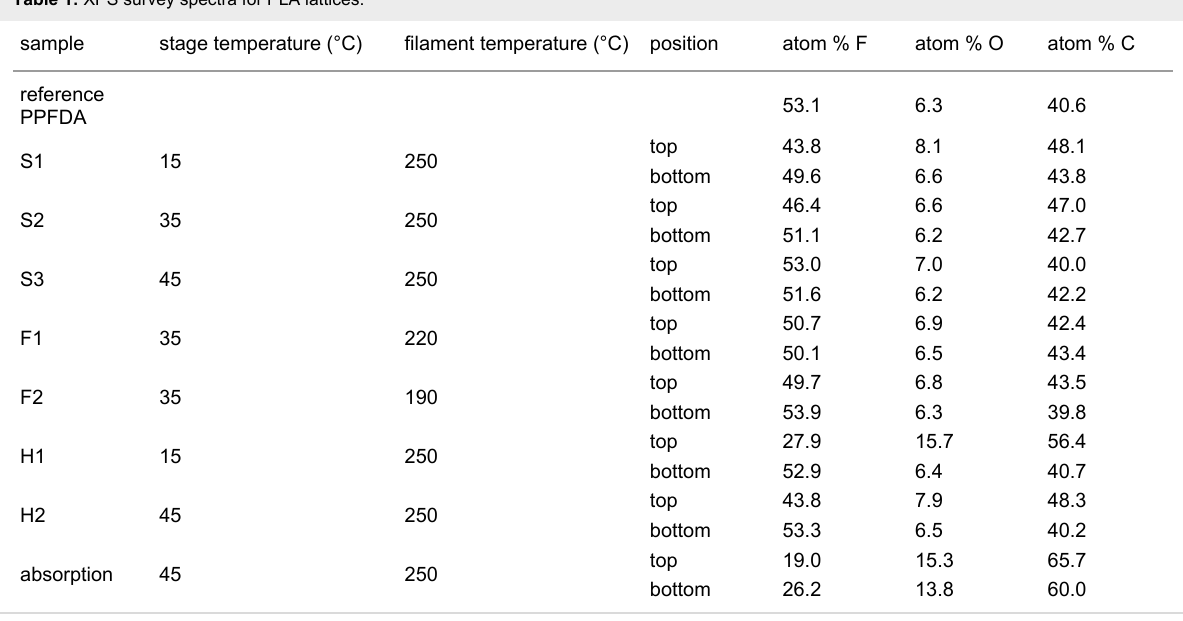
temperature at the top of the lattice was measured to be 62 °C, 77 °C and 80 °C, respectively. These temperature differences of ca. 30 °C are due to the large height and thermally insulating properties of the PLA lattice. After PPFDA deposition at a stage temperature of 15 °C (sample S1), the contact angle of the lattice increased from (105 ± 2)° to (126 ± 5)° at the top and from (99 ± 8)° to (131 ± 4)° at the bottom. After PPFDA depo- sition at a stage temperature of 35 °C (sample S2), the contact angle at the top of the lattice increased from (109 ± 5)° to (127 ± 3)° at the top and from (104 ± 2)° to (139 ± 3)° at the bottom. After PPFDA deposition at a stage temperature of 45 °C (sample S3), the contact angle of the lattice increased from (111 ± 6)° to (125 ± 4)° at the top and from (105 ± 2)° to (133 ± 4)° at the bottom. These increases of the contact angle indicate that the lattices were coated at both the top and bottom at the three stage temperatures, despite the large